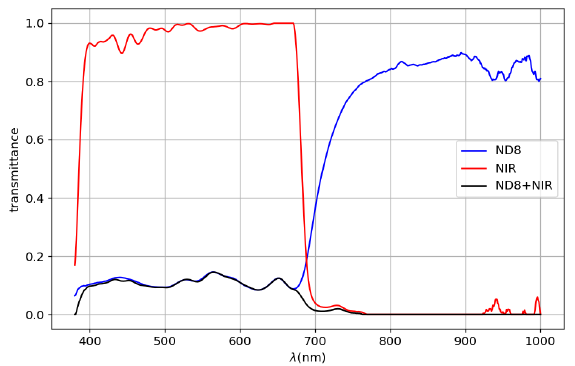
Figure 2. The transmittance spectra of the filters.